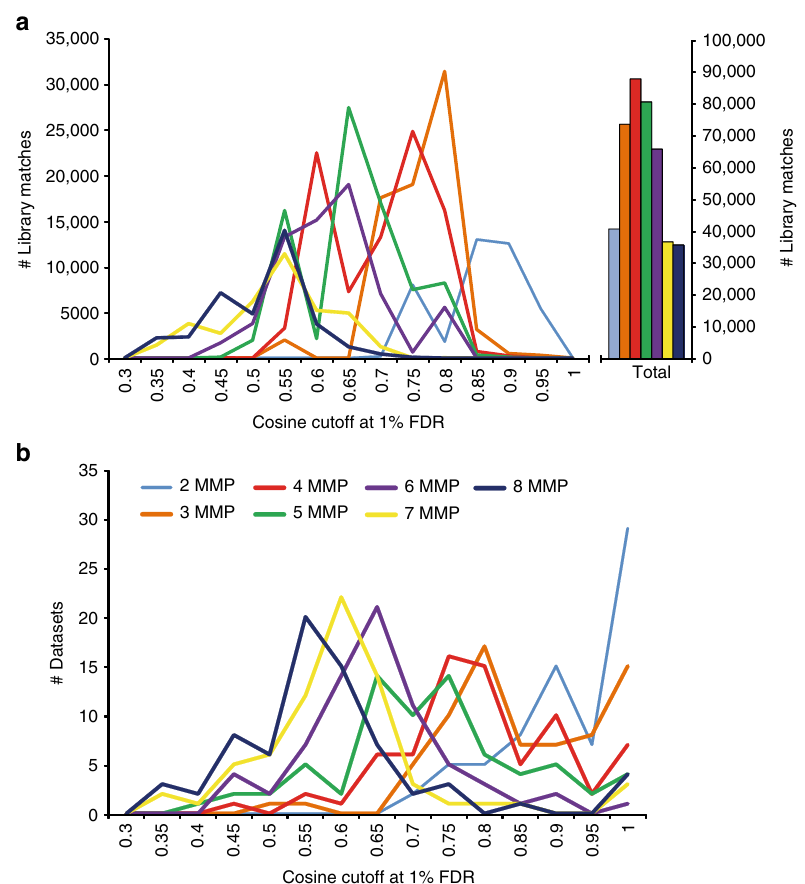
Fig. 4 The impact of number of matching fragment ions in a spectrum and cosine score at 1% FDR. a Frequency of data sets in relationship to number of MMP to match and cosine at 1% FDR estimation. b The number of MS/MS matches in relation to minimum matched fragment ions and cosine. An alternative 3D plot of these fi gures can be found in Supplementary Fig.